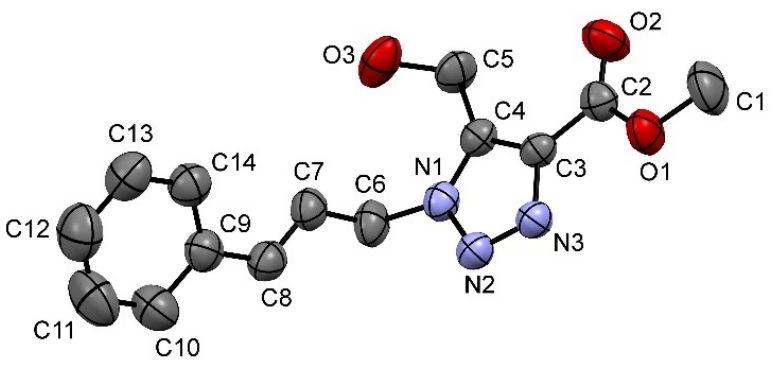
Figure 1. X-ray crystallography-derived thermal ellipsoid plot of compound 3f .